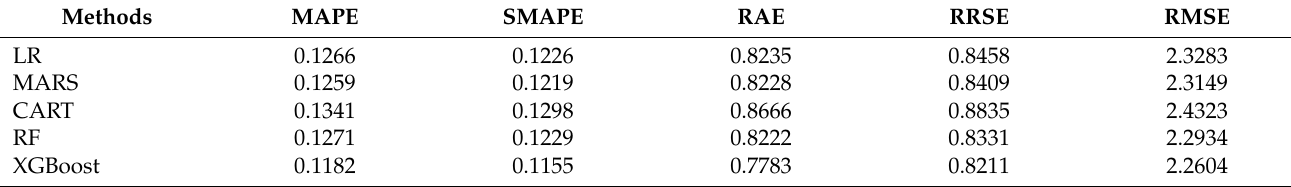
Table 4. Model performance of LR, MARS, CART, RF, and XGBoost